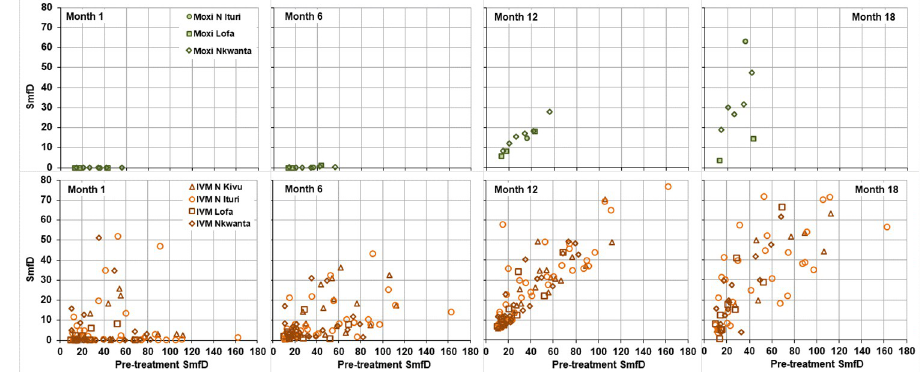
Fig 9. SmfD at Month 1, 6, 12 and 18 vs pre-treatment SmfD for the 10 moxidectin and 88 ivermectin treated participants with ‘suboptimal response’ participants with ‘suboptimal response’. IVM ivermectin, Moxi moxidectin, SmfD Skin microfilariae